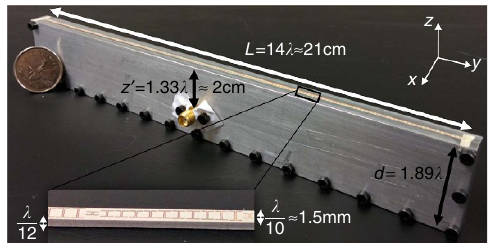
Figure 5 | Fabricated cavity-excited HMS antenna. Probe-fed cavity excites a l /10-wide L ¼ 14 l -long metastrip implementing the simulated design corresponding to Fig. 6b, based on the spider unit cells. The two metallic walls parallel to the b yz plane form a 2D excitation environment, while the two (shorter) metallic walls parallel to the b xz plane form the lateral cavity. Inset: close-up of a section of the metastrip before integration with the